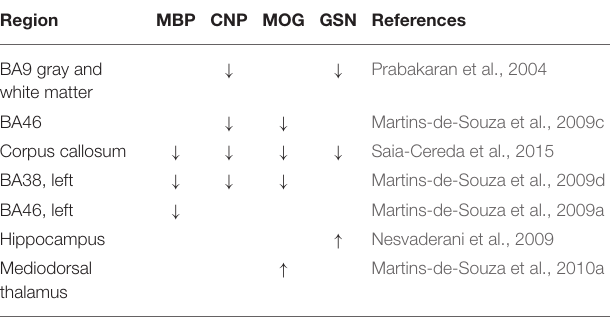
TABLE 4 | Oligodendroglial proteins most commonly cited.